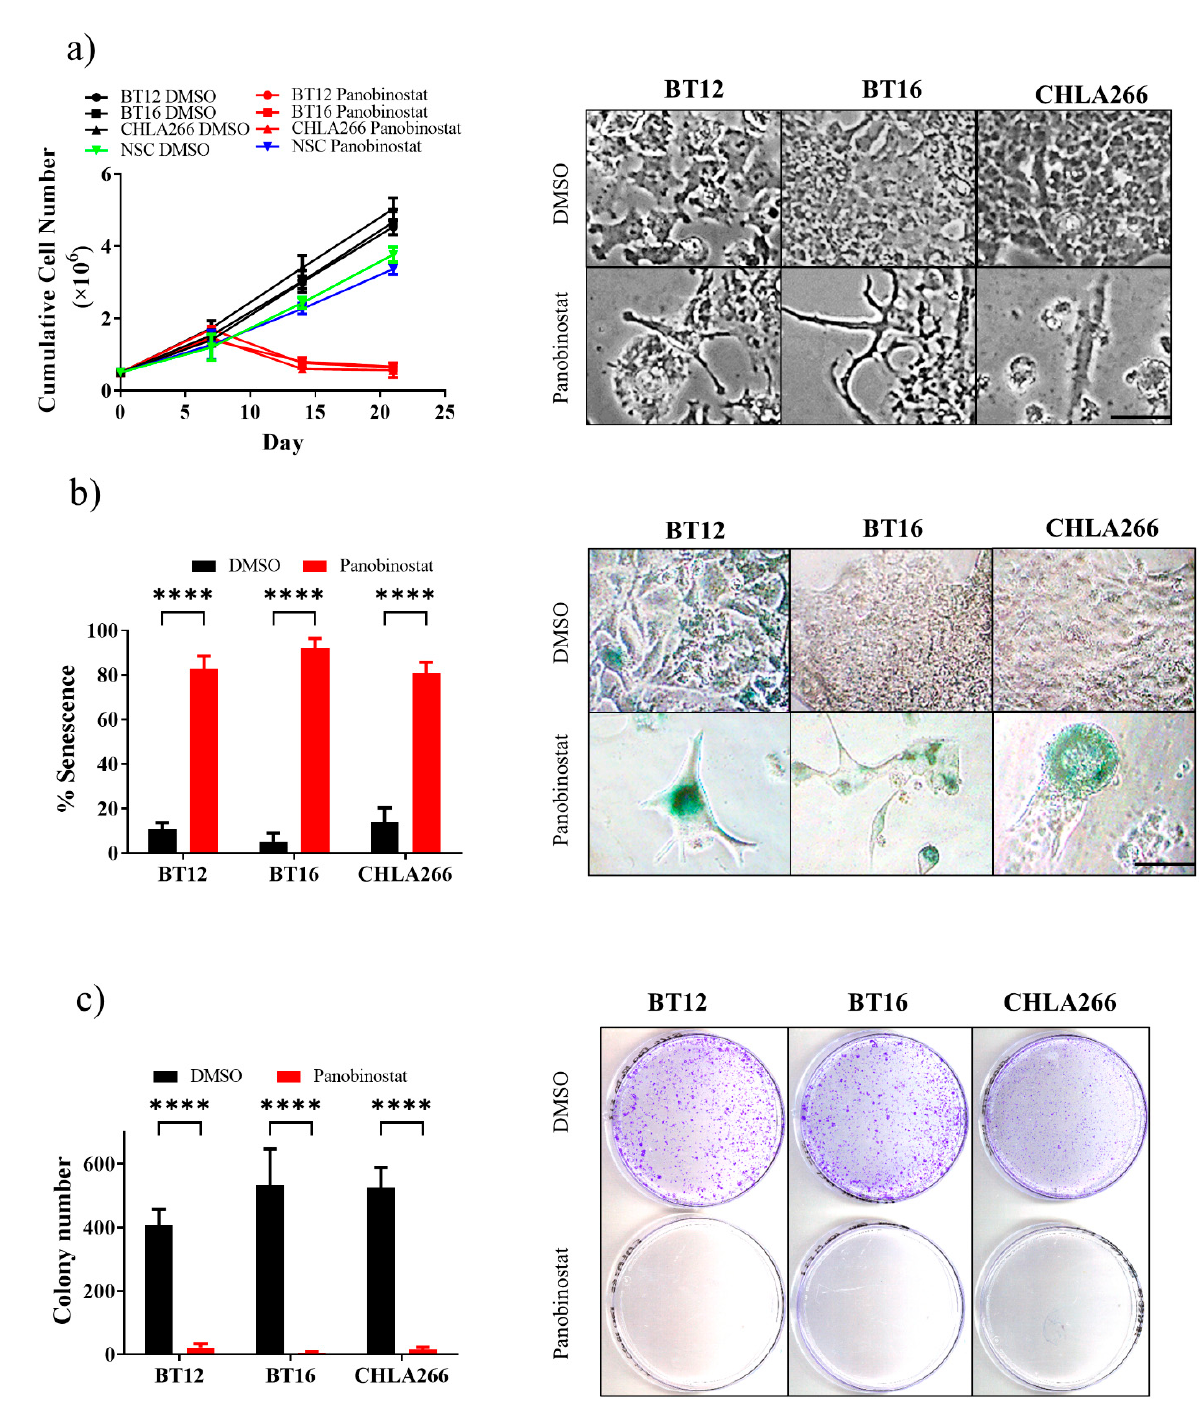
Figure 2. Continuous 10 nM panobinostat treatment reduces cell growth, colony formation and induces cellular senescence in human ATRT cells. ( a ) Cumulative cell growth of ATRT cells, BT12, BT16, and CHLA266, and NSC cells challenged with continuous 10 nM panobinostat or DMSO vehicle control for 21 days ( n = 3; mean ± SEM). Light microscopy images depict cellular morphology of BT12, BT16, and CHLA266 following 21 days treatment. Scale bar = 100 µ m. ( b ) Quantitation and light microscopy of senescence-associated β -galactosidase assay on ATRT cells, BT12, BT16, and CHLA266, treated with sustained 10 nM panobinostat or DMSO vehicle control for 21 days ( n = 3; mean ± SEM; ****, p < 0.0001). Scale bar = 100 µ m. ( c ) Quantitation and representative images of colony formation potential in ATRT cells, BT12, BT16, and CHLA266, treated with continuous 10 nM panobinostat of DMSO vehicle control for 21 days ( n = 3; mean ± SEM; ****, p <